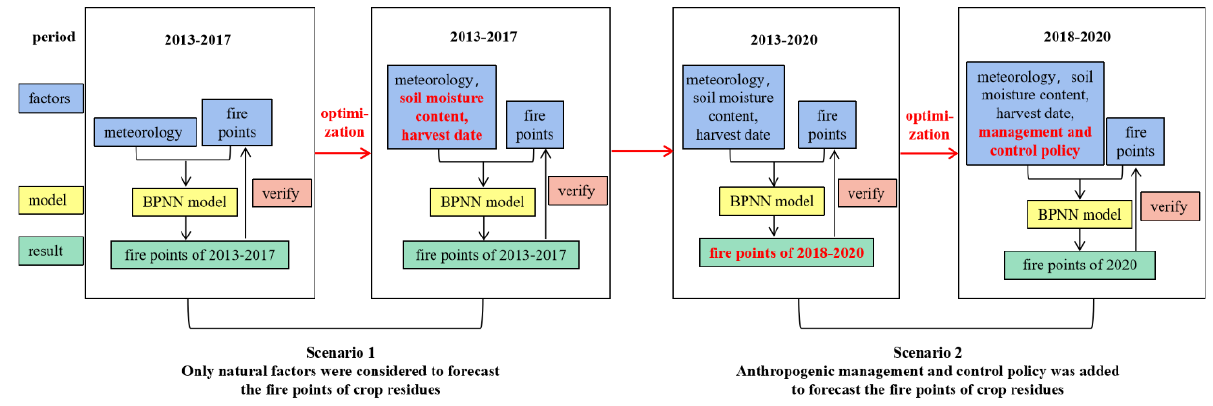
Figure 3. Research flow chart showing the BPNN methods used in this